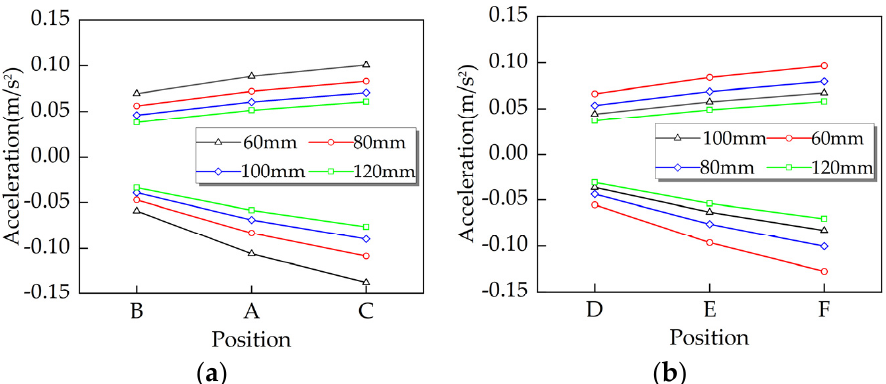
Figure 5. The effect of different positions on the plane on the peak acceleration: ( a ) point DEF; ( b ) point BAC.